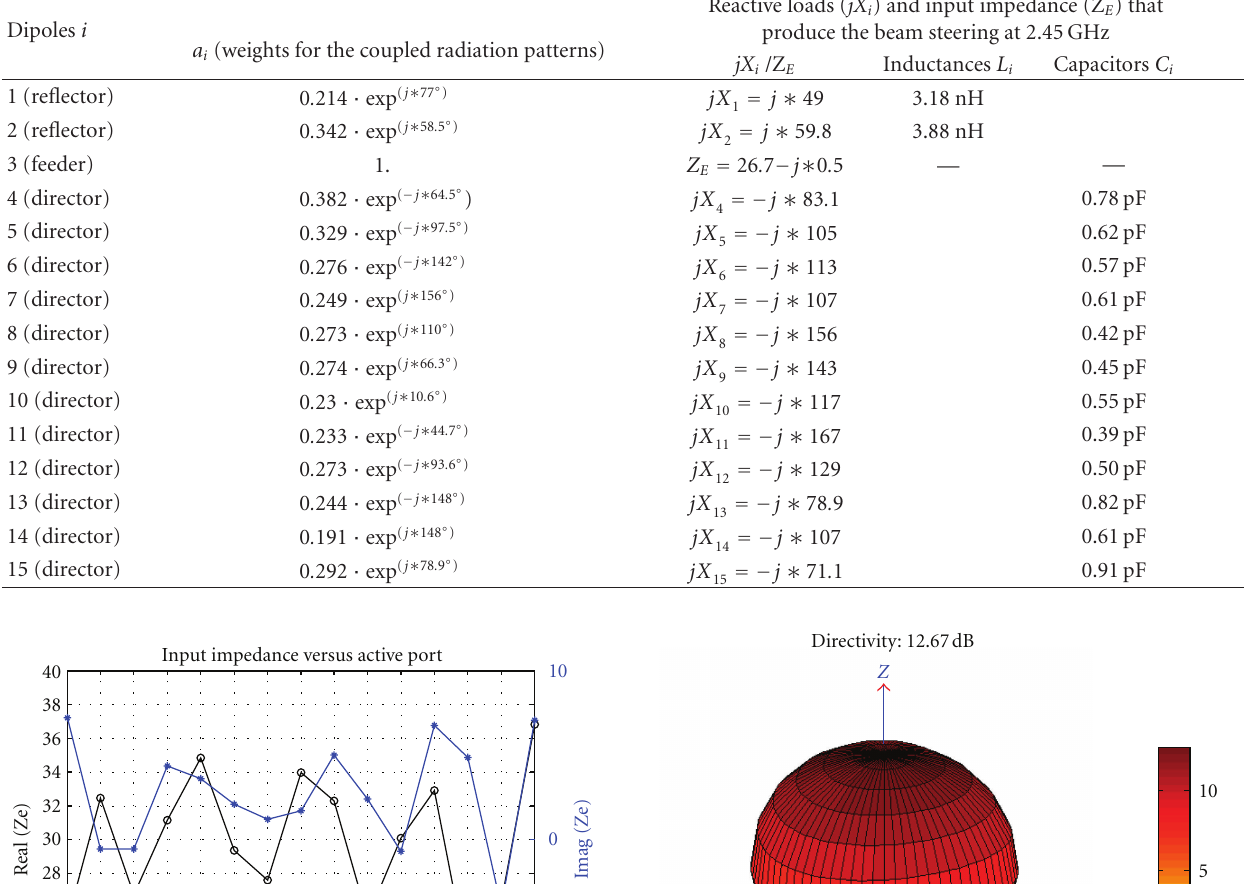
Table 5: Weightings for the coupled radiation patterns and reactive loads that are to connected to the non-fed dipoles. Dipoles i a i (weights for the coupled radiation patterns)